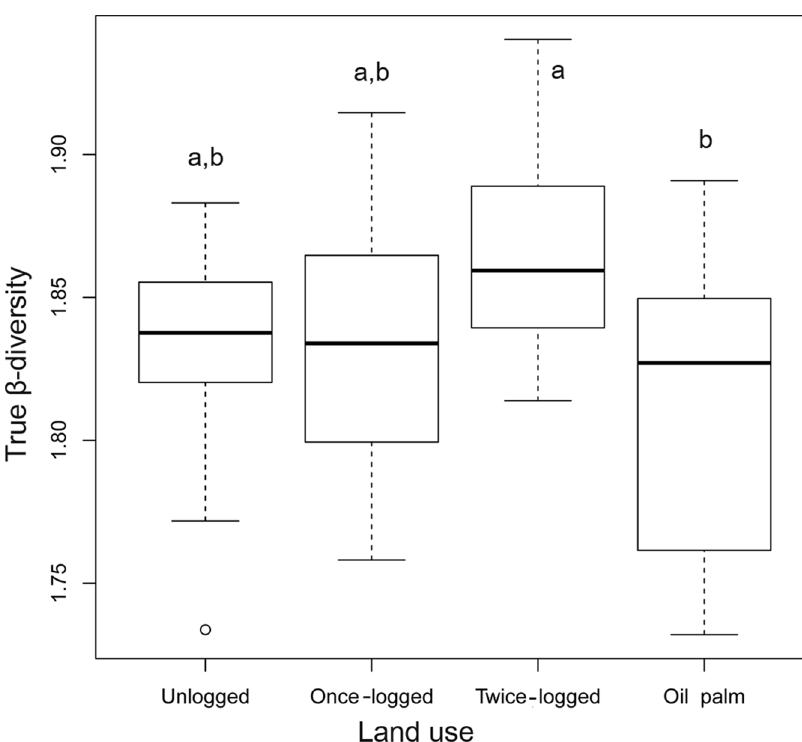
{ Figure 5. Fungal community true b -diversity (i.e. S = a ) among the four land uses in Sabah, Malaysian Borneo. Boxes show the lower quartile, the median and the upper quartile. Pairwise comparisons are shown; different letters denote significant differences between groups at P , 0.05.